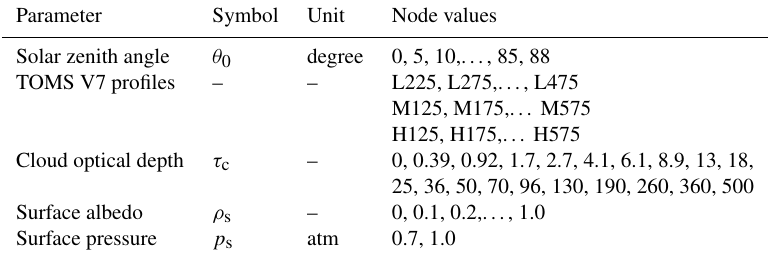
Table 2. Node points of the look-up table for the dose rates and UV irradiances at selected wavelengths. The full 26 profile set of the TOMS V7 climatology is used. L, M, and H refer to the low-, middle-, and high-latitude profiles, respectively, while the numbers refer to total ozone columns in DU.